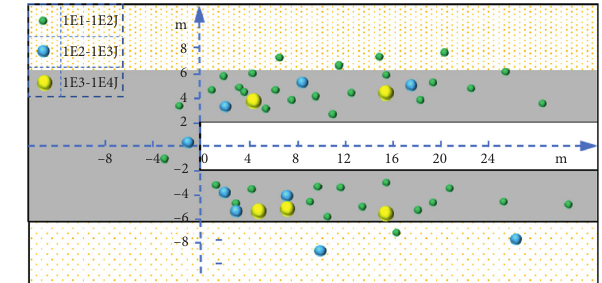
Figure 17: Spatial distribution of near-field microseismic events in the driving face after the application of “pressure relief and yielding support” joint prevention and control technology.